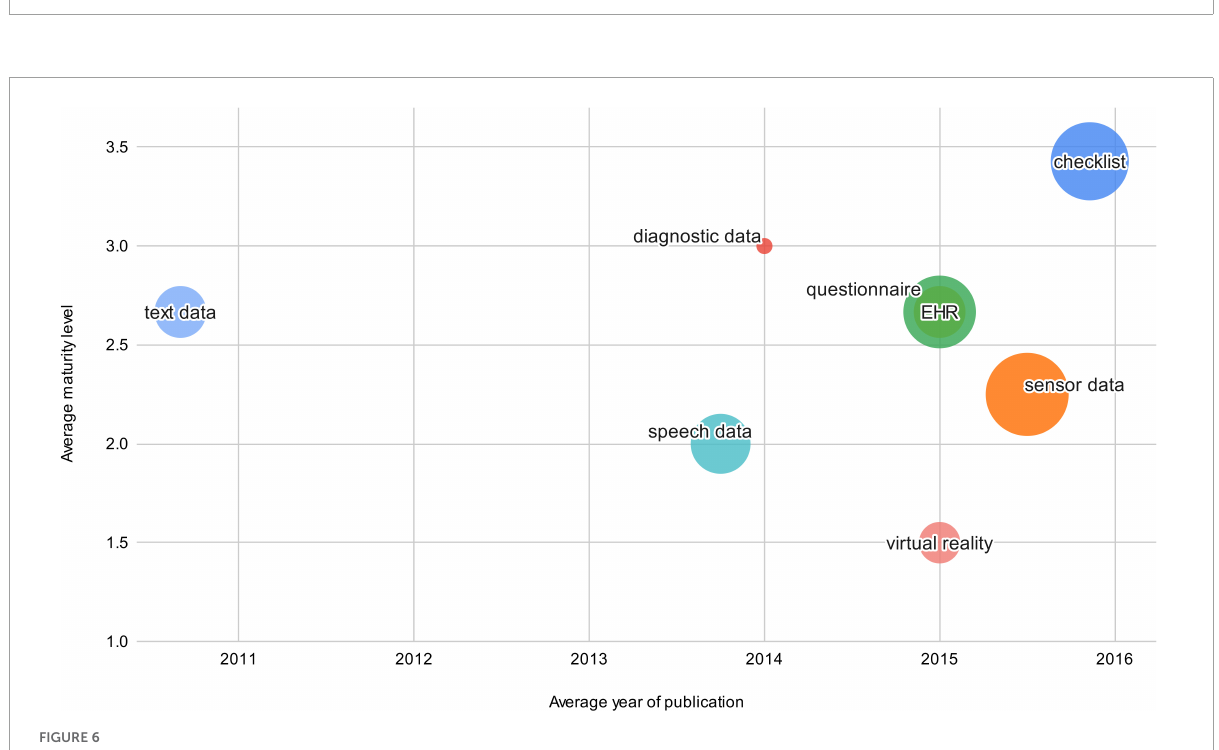
FIGURE5 Sample size distribution excluding outliers.